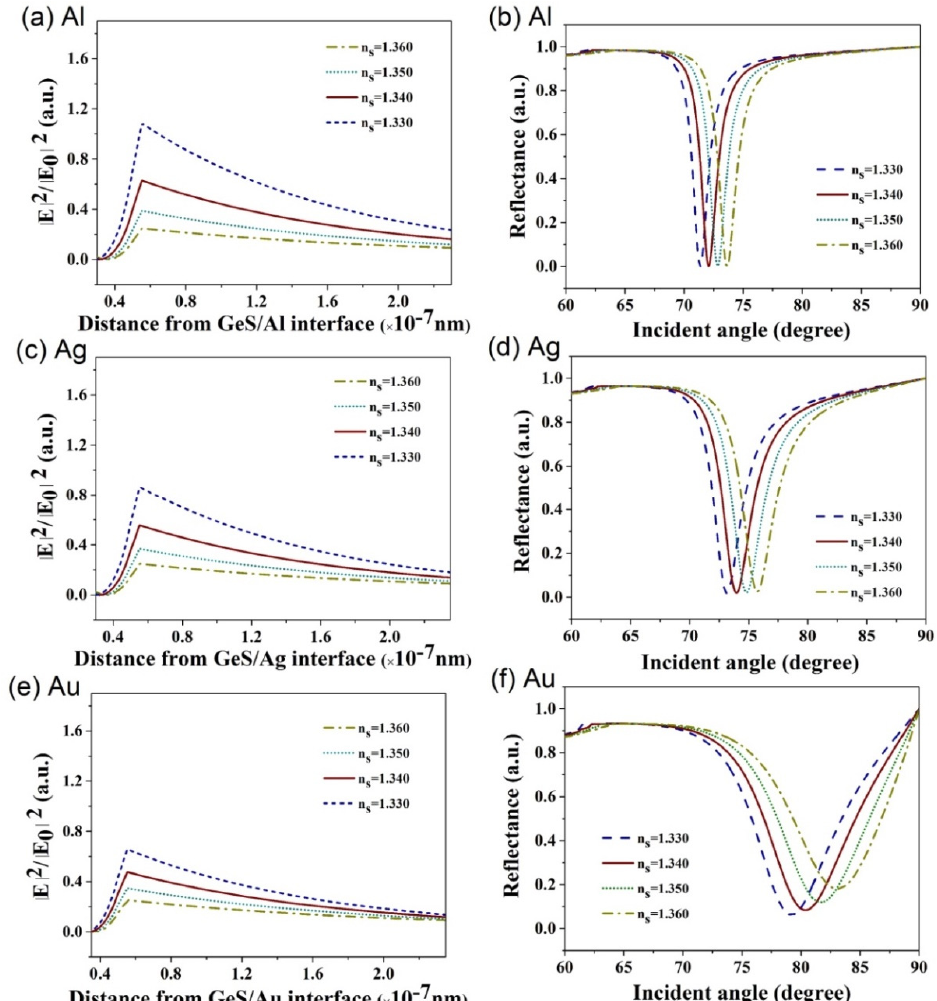
Figure 5. ( a , c , e ) The electric field distribution of the GeS based sensor and ( b , d , f ) variation in reflectance with the incident angle of the sensor based on few-layer GeS for n s = 1.33 to n s = 1.36.